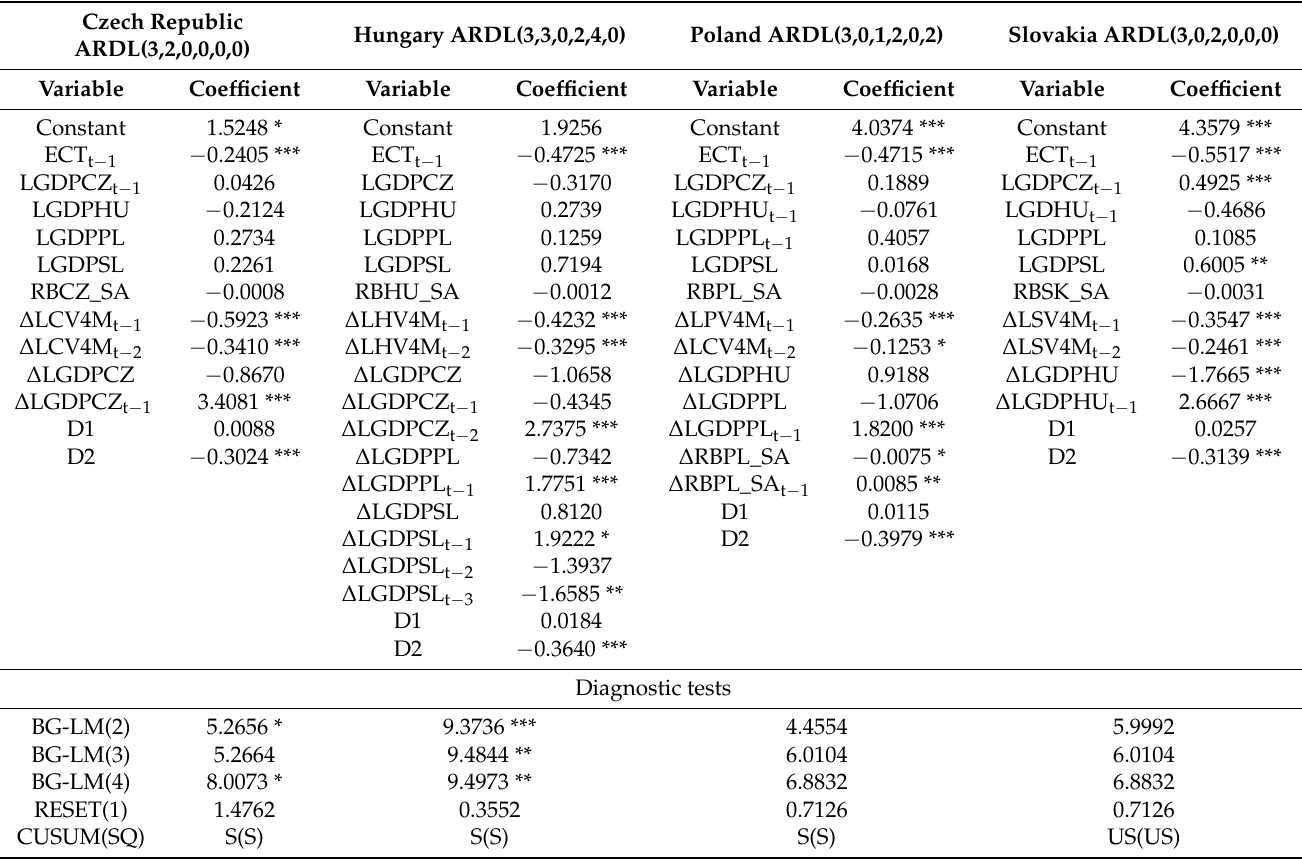
Table 4. ARDL model results for imports.